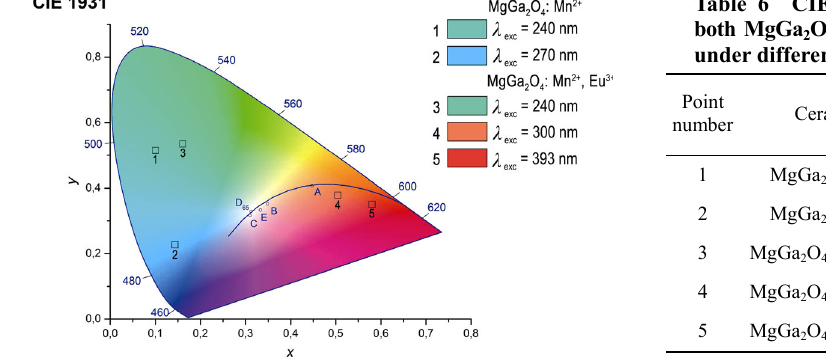
Table 6 CIE achromatic coordinates calculated